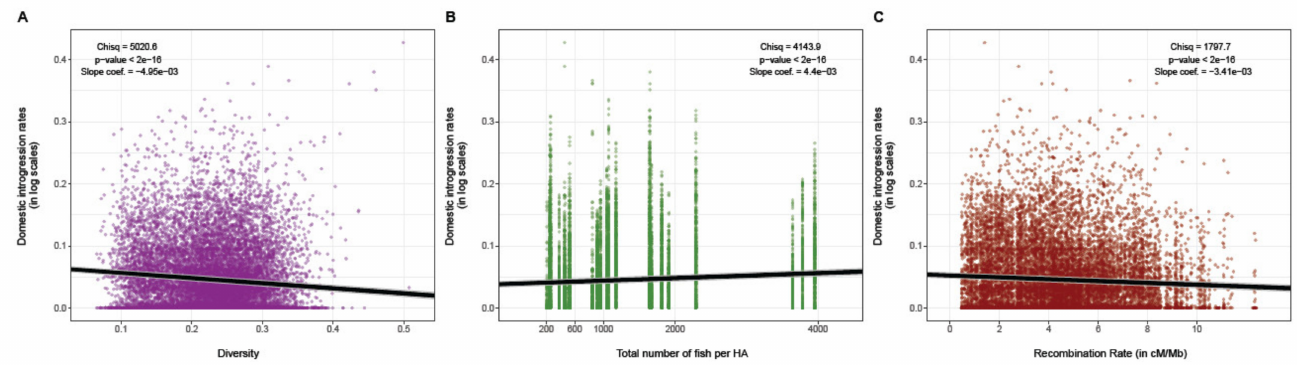
Figure 3. Whole genome relationship between the domestic ancestry and ( A ) genetic diversity, ( B ) stocking intensity and ( C ) local recombination rate, assessed with a generalized linear mixed model (GLM; R 2 c = 0.084, R 2 m = 0.015, AIC = − 1952637, − 3.418 × 10 − 3 , β − 4.950 × 10 − 3 , β × 10 − 3 , χ 2 = 4143.9, p < 2.2 × 10 − 16 ( B ); β Recombination = Diversity = Stocking = 4.441 p < 2.2 × 10 − 16 ). Grey lines represent the 95% confidence